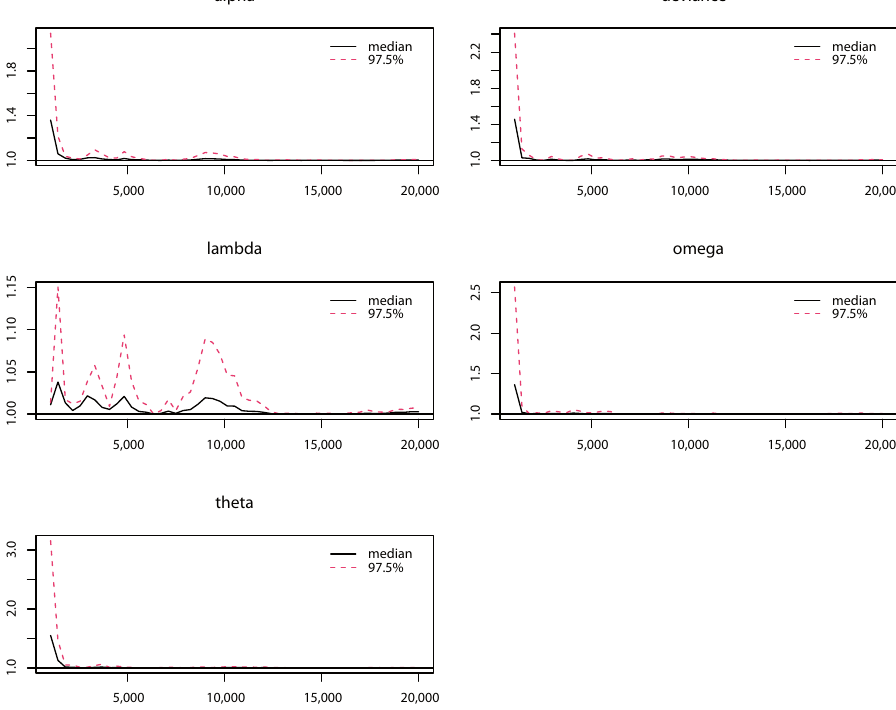
Figure 9. Gelman plot diagnostic for each CWE distribution parameter based on DS1